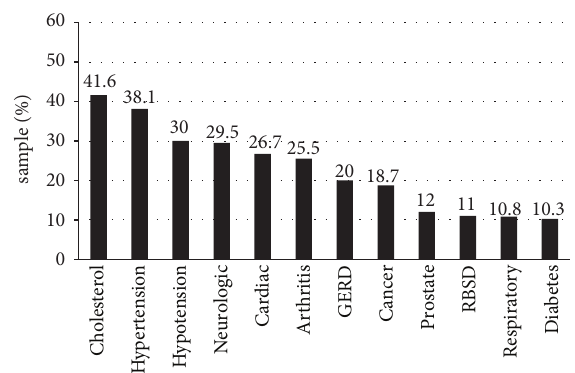
Figure 1: Prevalence of comorbidities in a convenience sample of 341 idiopathic Parkinson patients ( 𝑁 = 341 ). Shown is the per- centage of Parkinson patients with various comorbidities based on medical chart review; only comorbidities occurring in at least 10% of the sample are shown. GERD = gastroesophageal reflux disease; RBSD = rapid Eye Movement (REM) behavior sleep disorder. None have deep brain